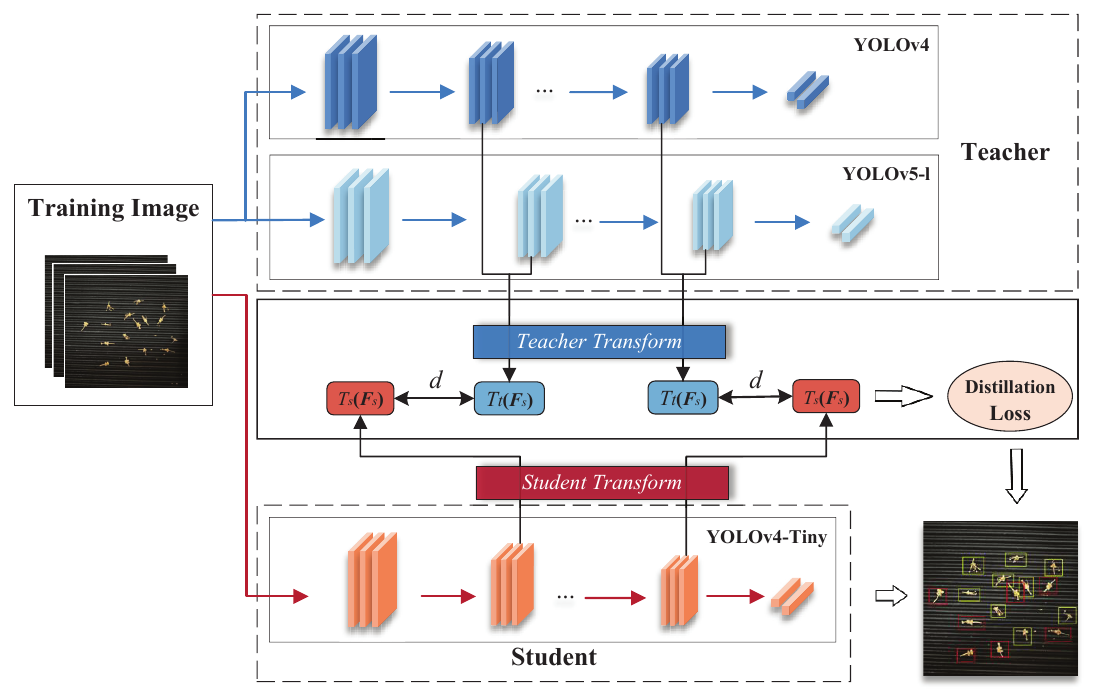
Figure 3. The framework of the YOLO-MPFD feature distillation network